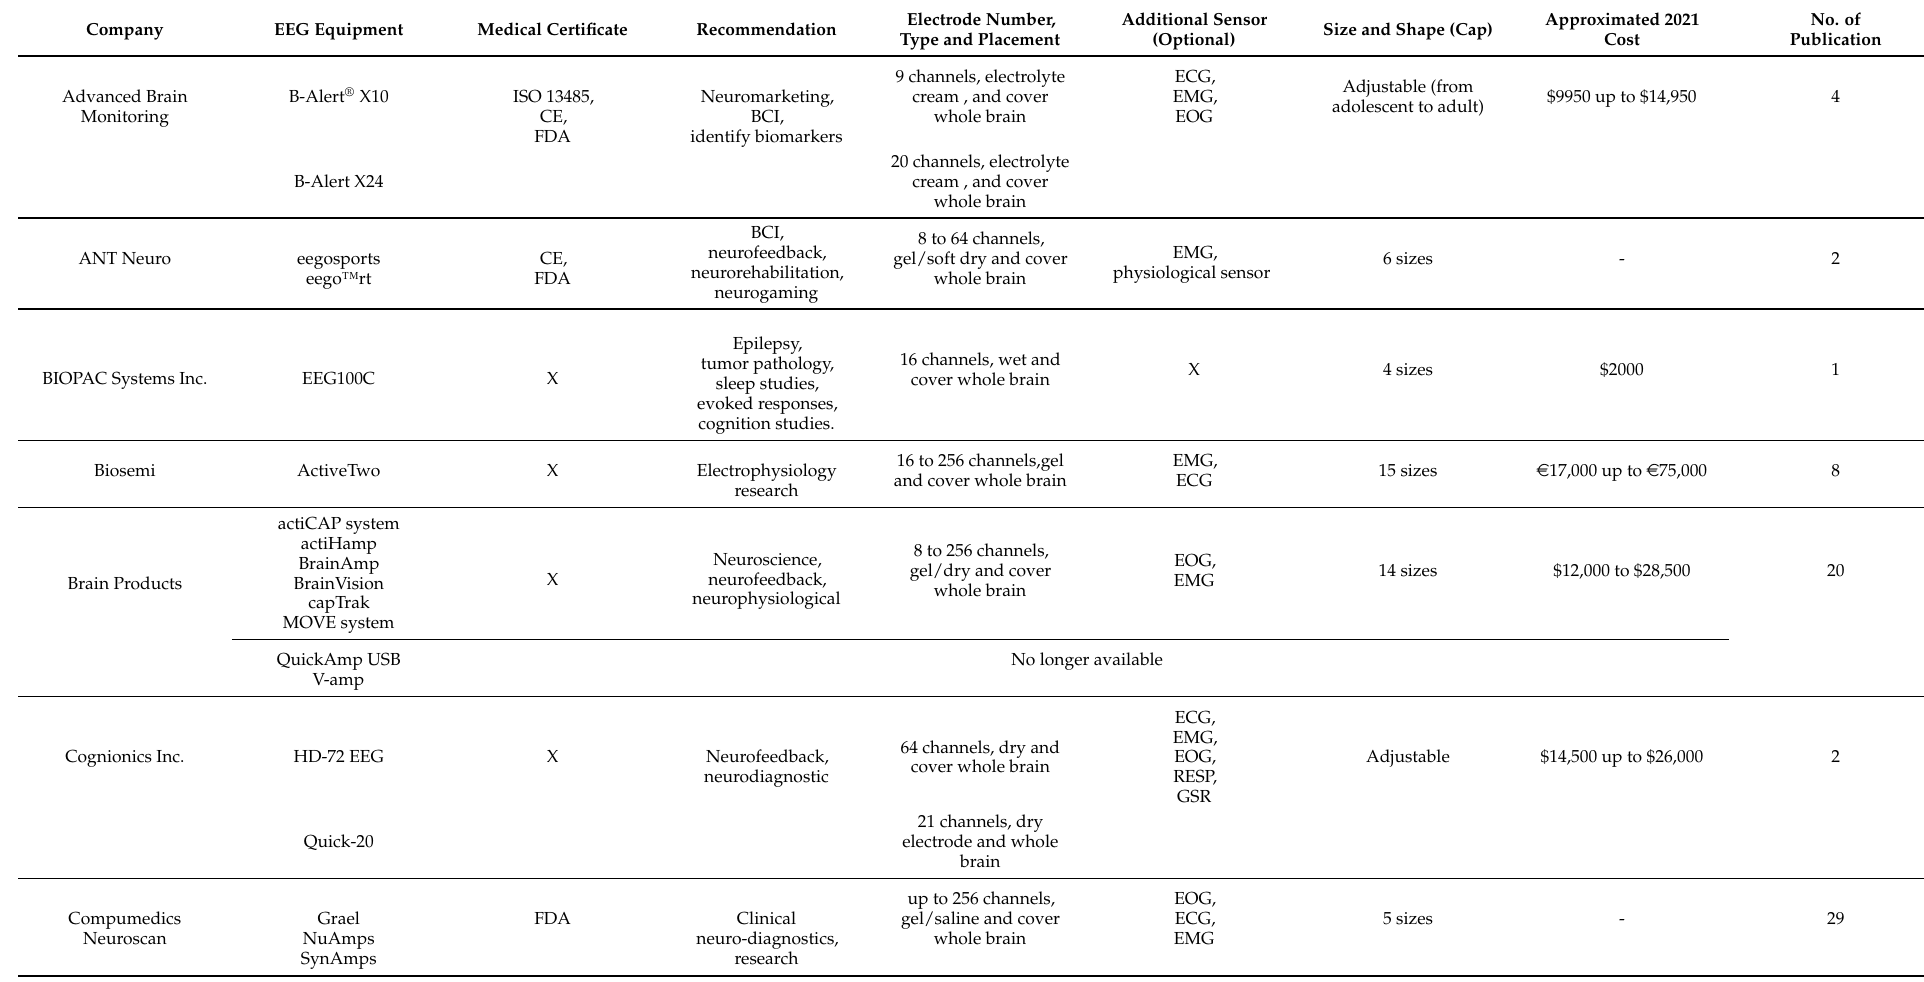
Table 3. A systematic comparison of the EEG